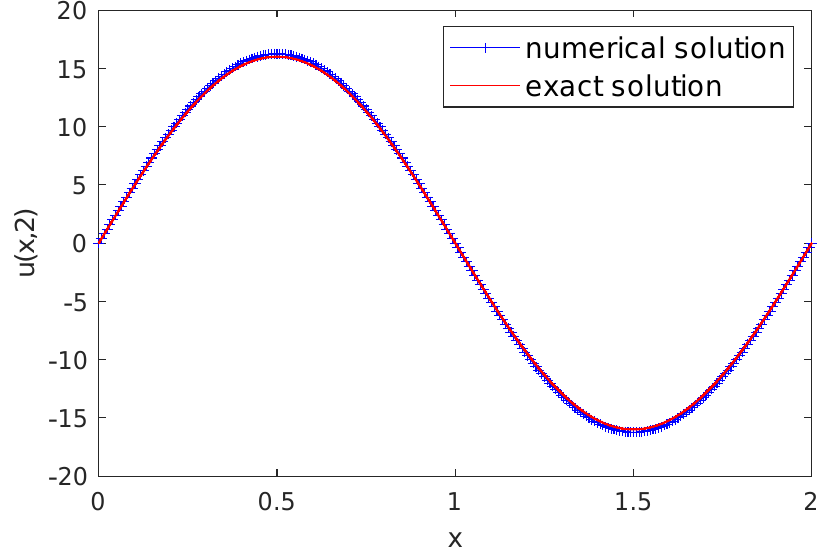
Figure 1. Graph of the displacement at t = 2 when α = 1.3, T = 2, L = 2, M = N =